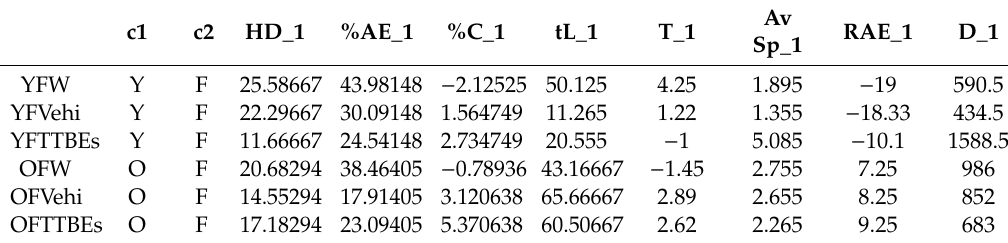
Table A2. Data matrix F 6,8 : female